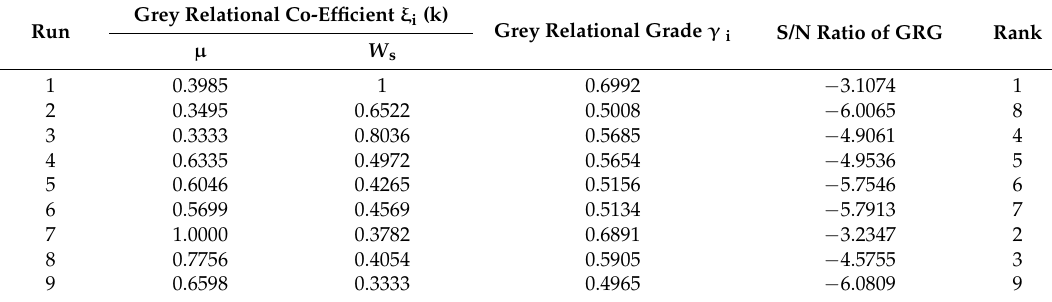
Table 9. Rank of grey relational grade (GRG) with S/N